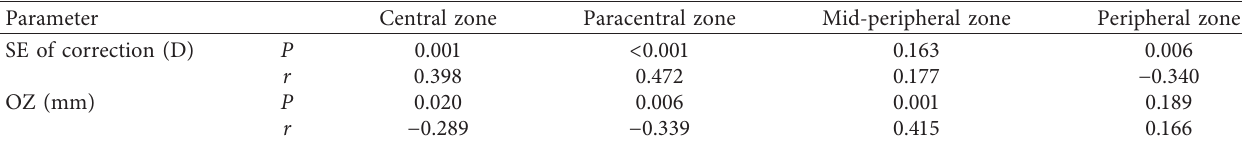
Table 4: Correlation between epithelial thickening and factors at six months postoperatively.